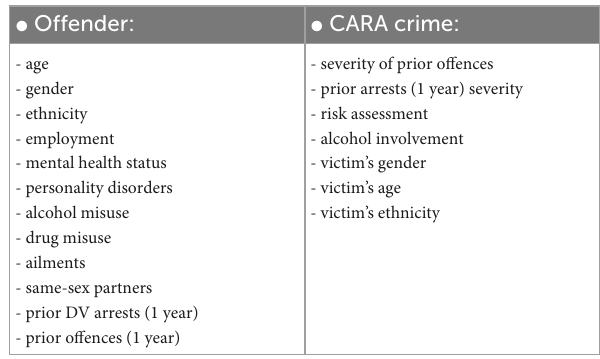
TABLE 4 Offender characteristics and CARA